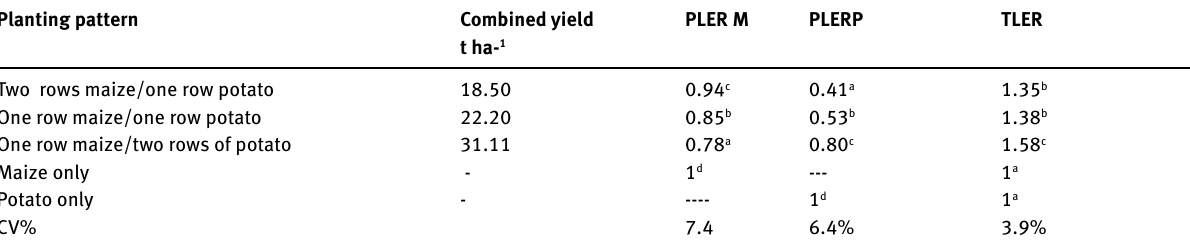
Table 3: Effect of spatial arrangement of maize/potato intercropping on combined yield and land equivalent ratios of the component crops (Hawzen 2012) Planting pattern Combined yield